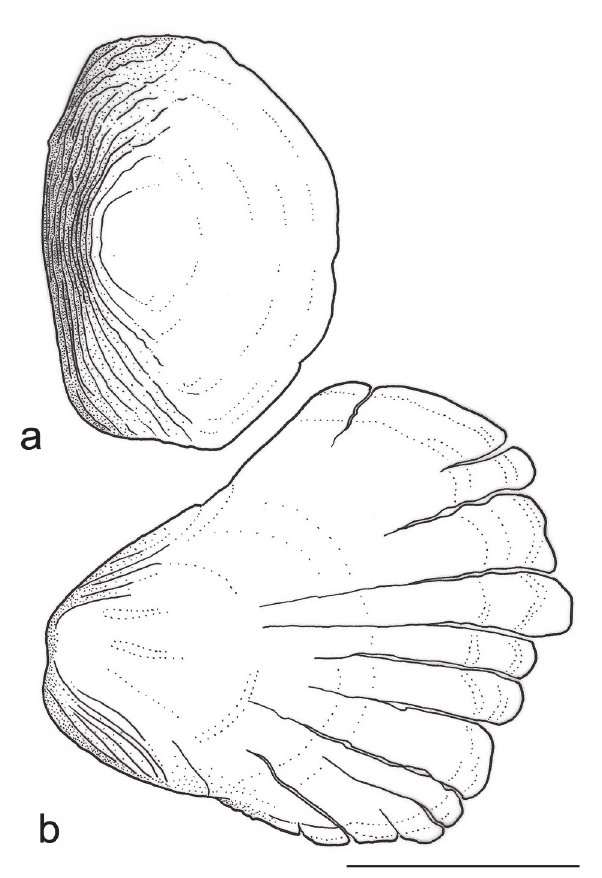
Fig. 6. Macropsobrycon uruguayanae , mature male, MCP 20900, 34.2 mm SL, left side, lateral view, a - lateral body scale and b - hypertrophied caudal-fin scale. Scale bar = 1